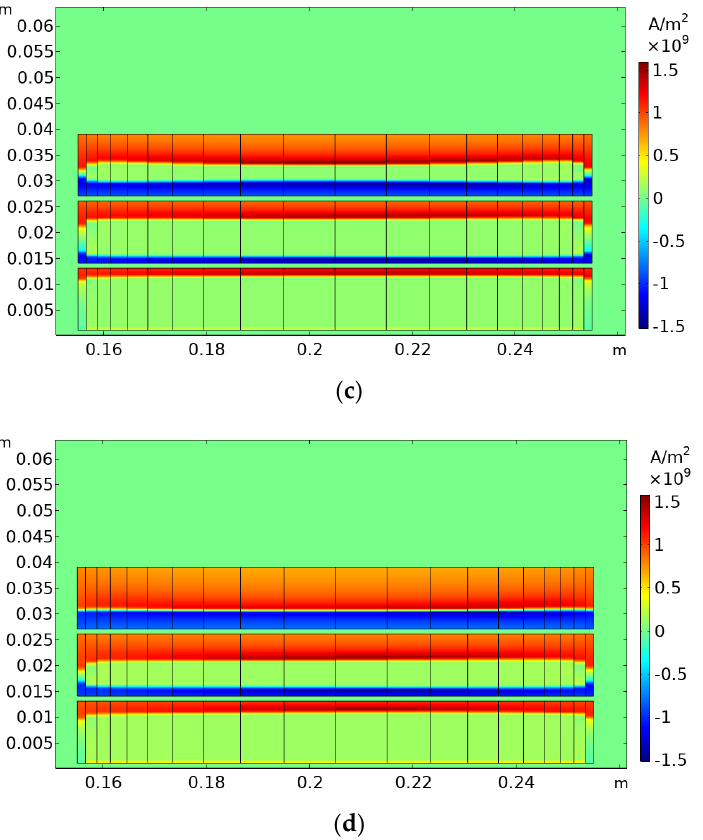
Figure 7. Electric current density distribution of the upper 3 HTS stacks with transport currents of ( a ) 200, ( b ) 400, ( c ) 600, and ( d ) 800 A.